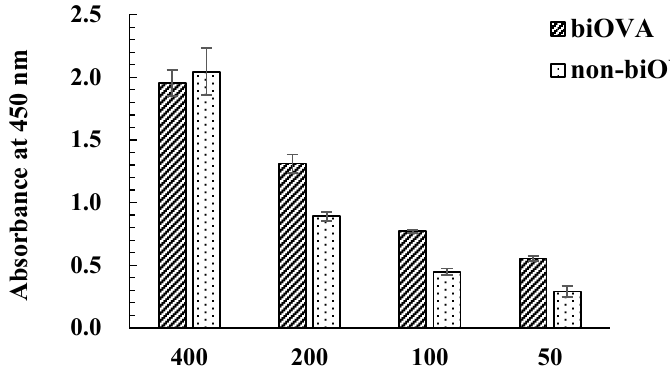
Figure 3. Optimization of biOVA concentration. biOVA and non-biOVA were diluted with PBS-T (50, 100, 200, and 400 µg/mL) and applied to iELISA.